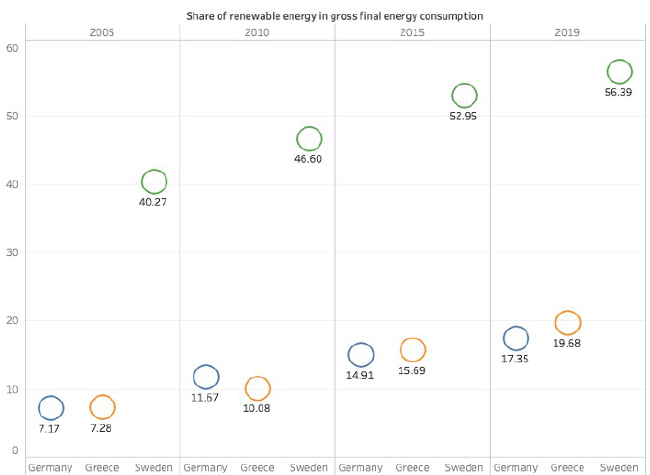
Figure 2. Share of renewable energy in gross final energy consumption in Sweden, Germany, and Greece (%).